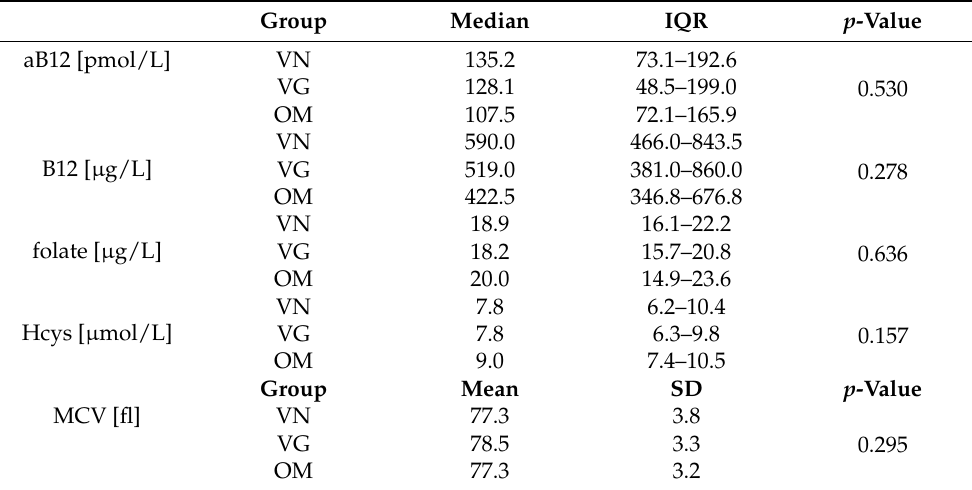
Table 8. Mean values of selected blood markers across VG/VN/OM “Infants and Toddlers” (aged 0.5–3 years).